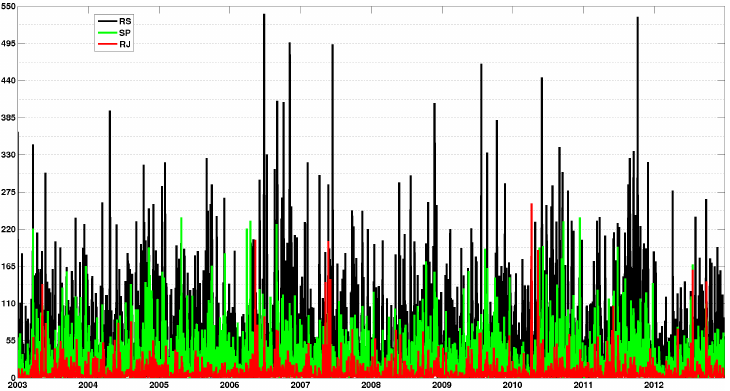
Figure 4. Time series of integrated power (kW · day − 1 ) considering entire sites. For interpretation of color in this Figure, the reader is referred to the web version of the article. These data are available as supplementary materials file on this article.